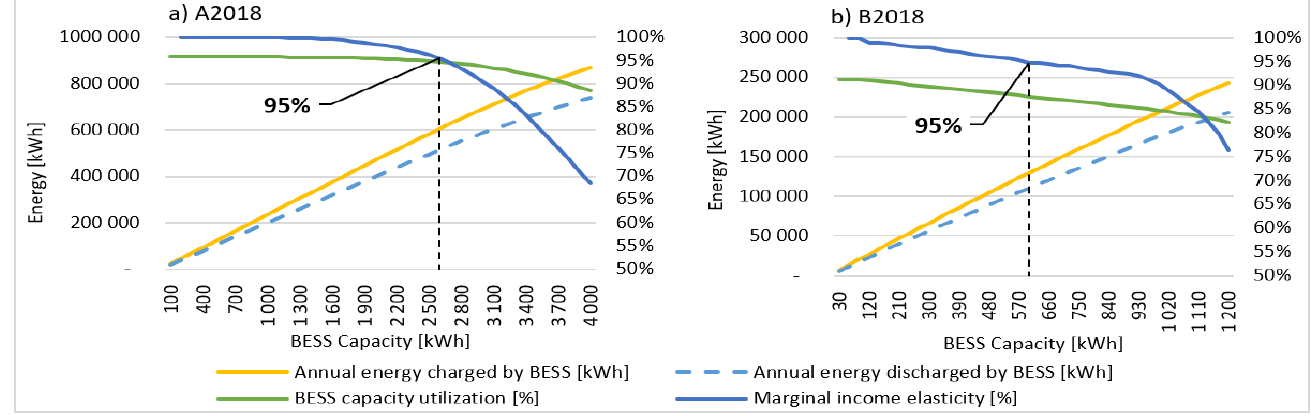
Figure 6. The results of the price arbitrage simulation for enterprises ( a ) A2018; ( b ) B2018.